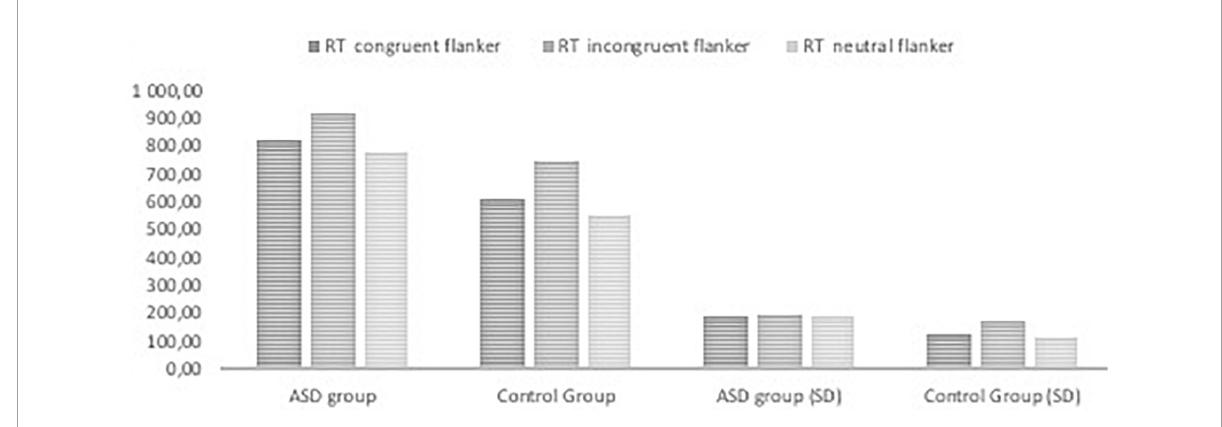
FIGURE2 Reaction time in the ANT tasks with congruent, neutral, and incongruent flankers in ASD group and control group.